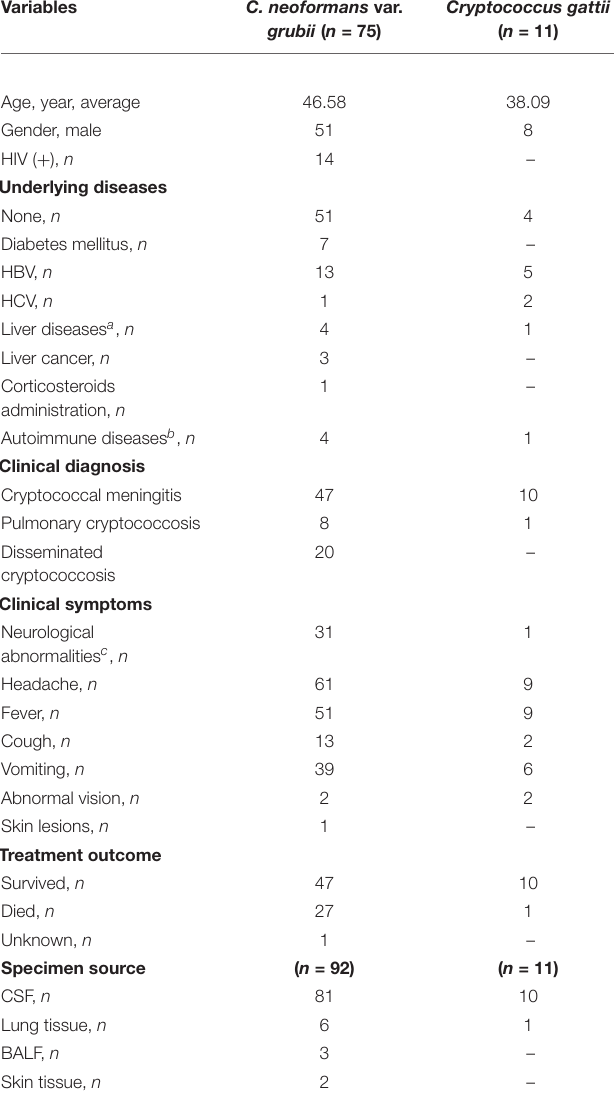
TABLE 1 | Demographic and clinical characteristics of the 86 patients with